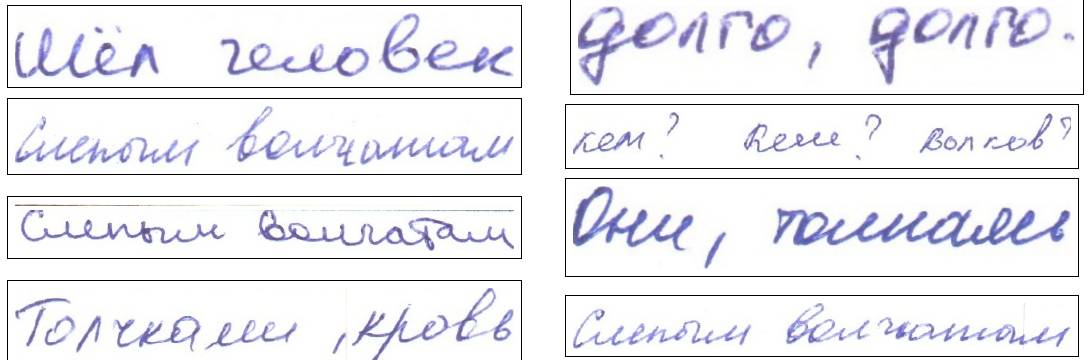
Figure 4. Some sample images from the HKR